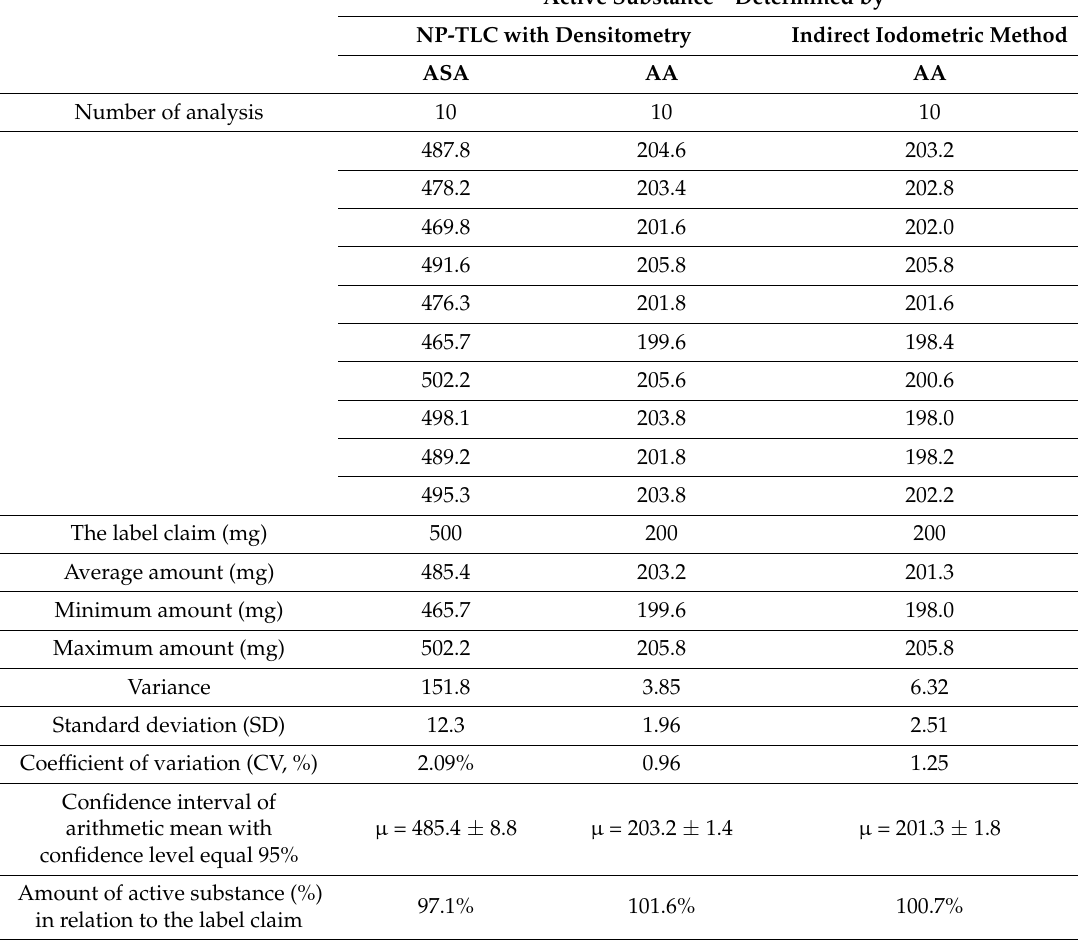
Table 5. The statistical data concerning the results of the quantitative determination of active substances in combined effervescent tablets examined by NP-TLC with densitometry and the indirect iodometric